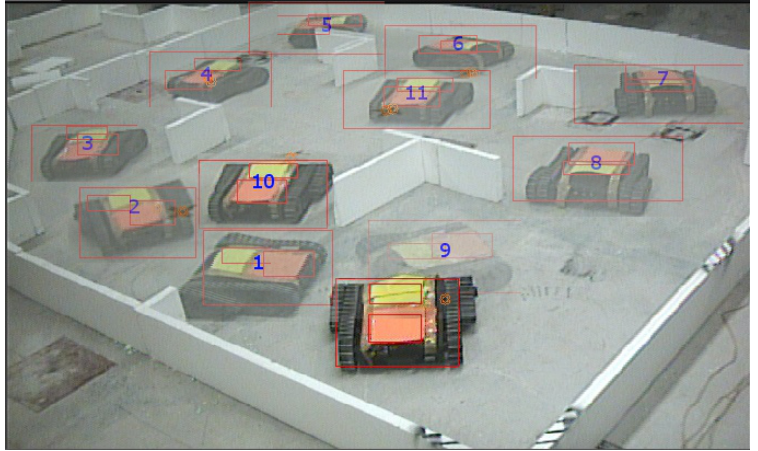
Figure 11. Deployment of a Jaguar V2 for single robot autonomous exploration